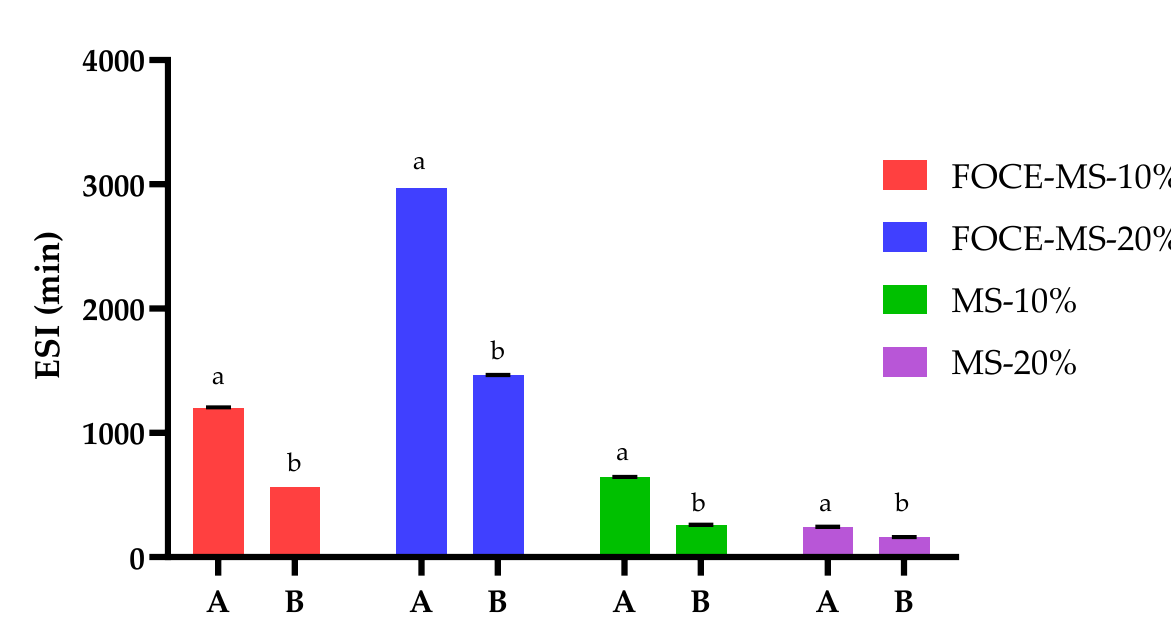
Figure 2. Emulsion Stability Index (ESI) of emulsions before spray drying A and after reconstitution B. FOCE-MS-